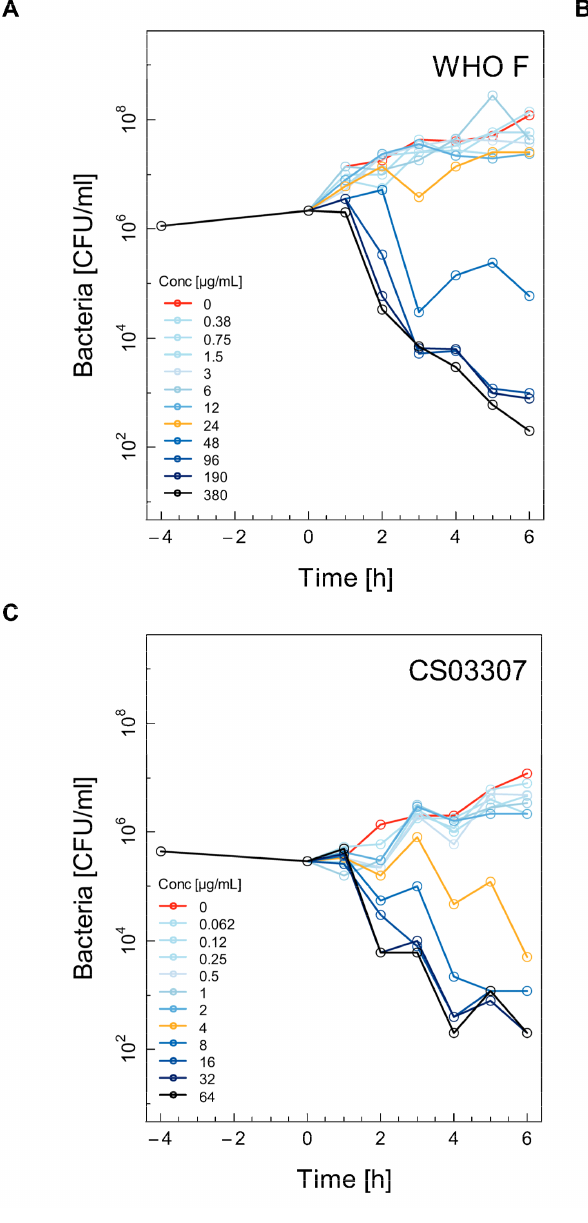
Figure 3. Selected time–kill curves (TKC) for three different strains of Neisseria gonorrhoeae using fosfomycin. For each combination of antibiotic and strain, the TKC from one of the three independent experiments is shown: WHO F ( A ), WHO X ( B ), CS03307 ( C ). See the legend for Figure 1 for further